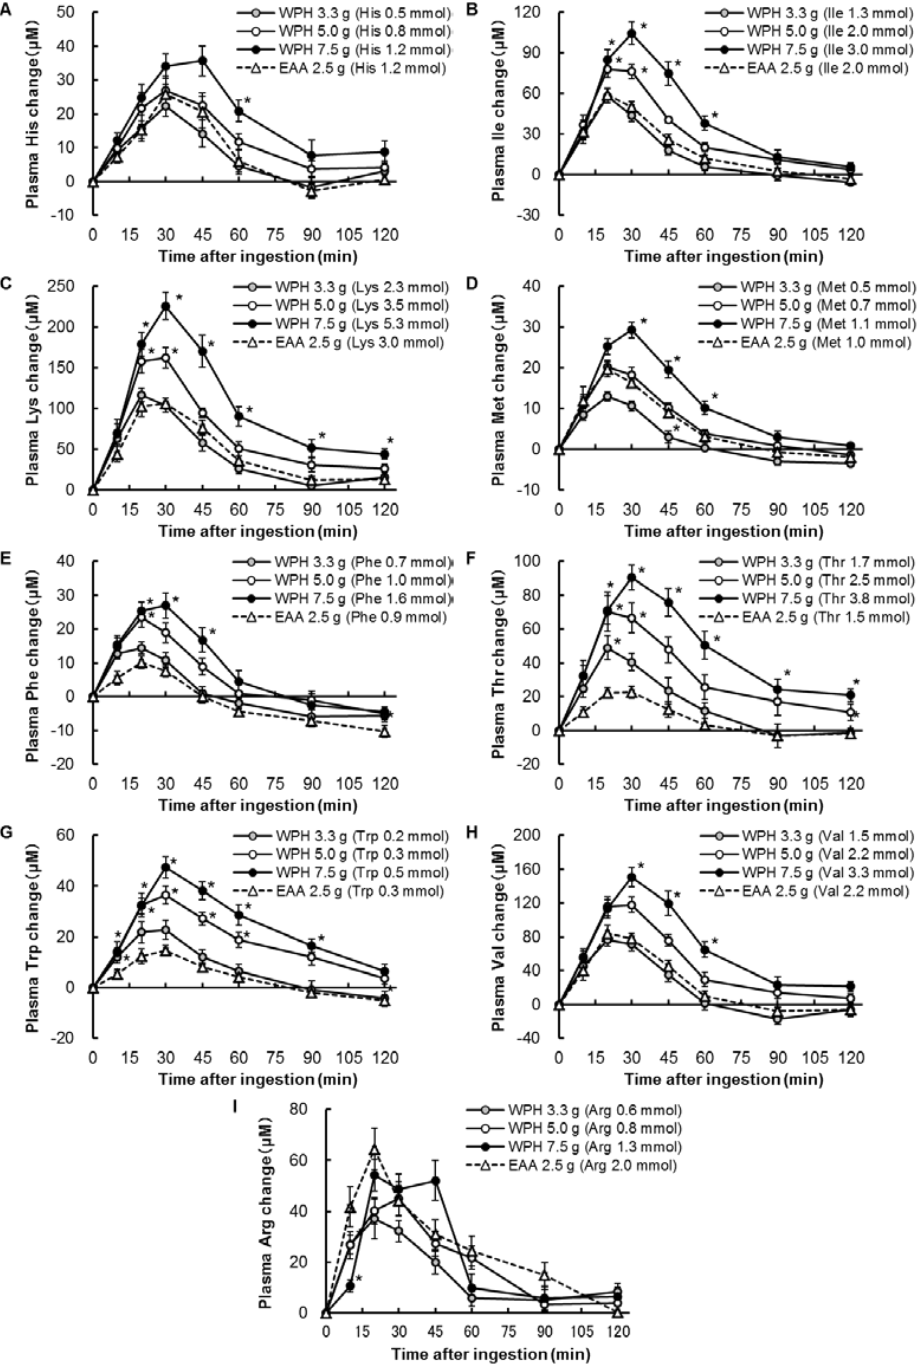
Figure 3. Plasma amino acids concentration changes from baseline. ( A ), His; ( B ), Ile; ( C ), Lys; ( D ), Met; ( E ), Phe; ( F ), Thr; ( G ), Trp; ( H ), Val; ( I ), Arg. Values are mean ± standard error of the mean. * Significantly different from EAA, p < 0.05. His: histidine; Ile: isoleucine; Lys: lysine; Met: methionine; Phe: phenylalanine; Thr: threonine; Trp: tryptophan; Val: valine; Arg: arginine; WPH: whey protein hydrolysate; EAA: essential amino acids.